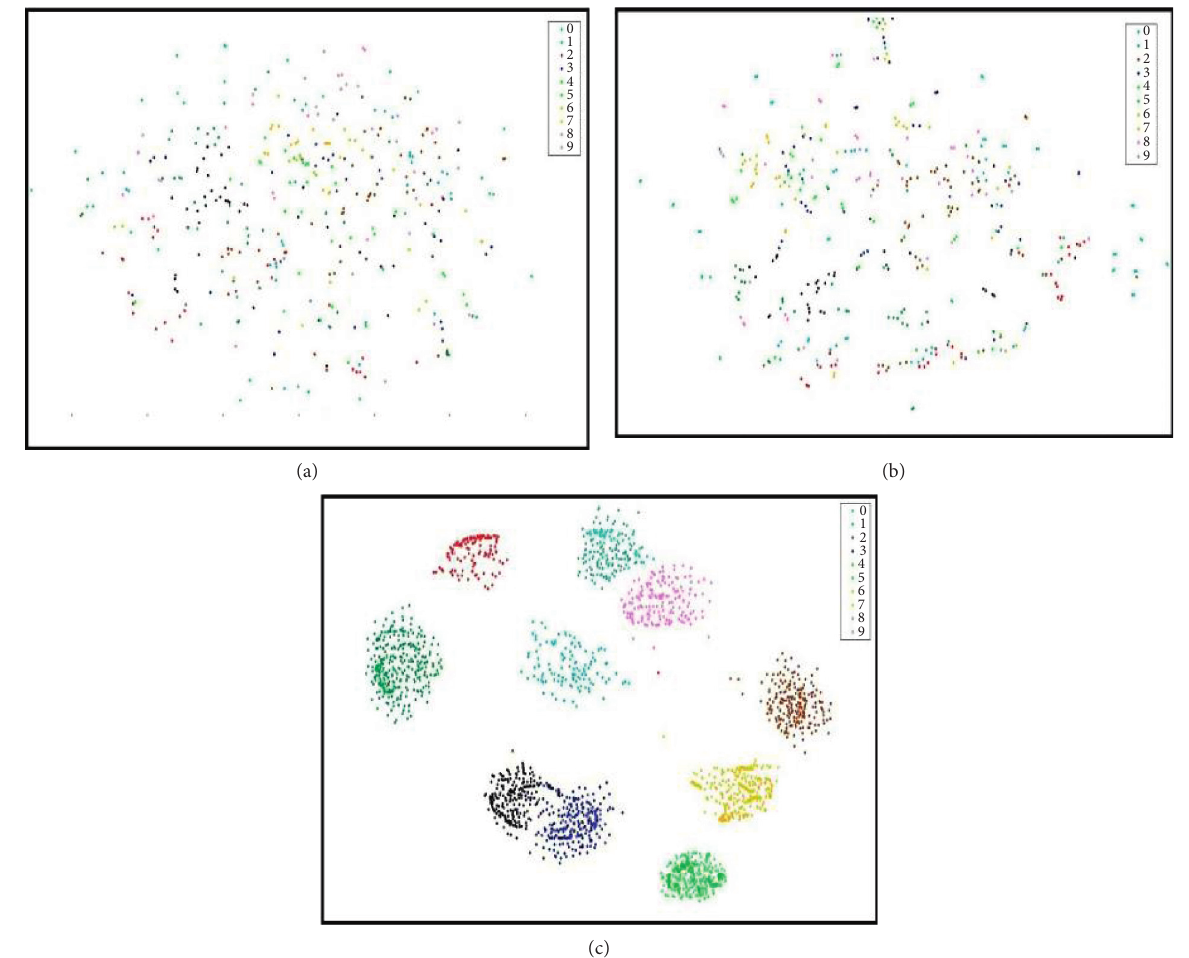
Figure 10: The visualization results of the high-dimensional fusion matrix data of the Urdu handwritten Urdu numerals using (a) autoencoders, (b) principal component analysis and (c) t